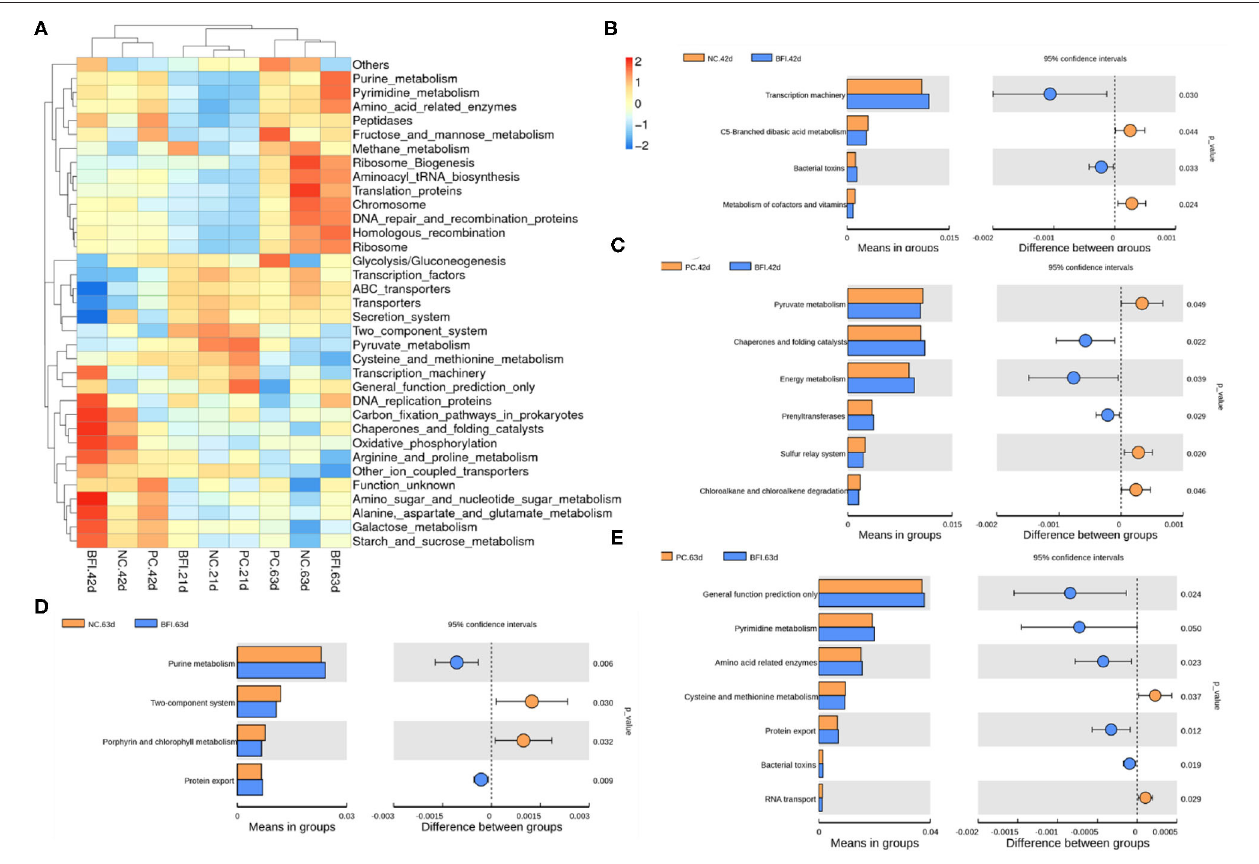
FIGURE 6 | Predicted microbial function of cecal microbiota in yellow-feathered broilers. (A) The heatmap of microbial functions predicted by PICRUSt. (B–E) The comparisons of cecal microbial functions between treatments at different ages. Statistics were conducted by two-sided Welch’s t -test and Benjamini-Hochberg FDR correction between pairs of means, with P -value lower than 0.05 indicating a significant difference in microbial function at Level 3 of KEGG pathways. NC, negative control without in-feed antibiotics. PC, positive control with in-feed antibiotics with 200 mg/kg of oxytetracycline calcium + 250 mg/kg of nasiheptide. BFI, compound probiotics consisting of heat-inactivated Bacillus subtilis and Lactobacillus acidophilus